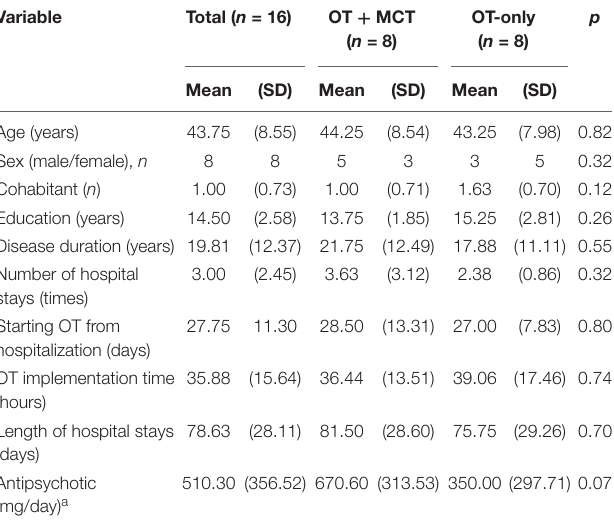
TABLE 1 | Demographic characteristics of the